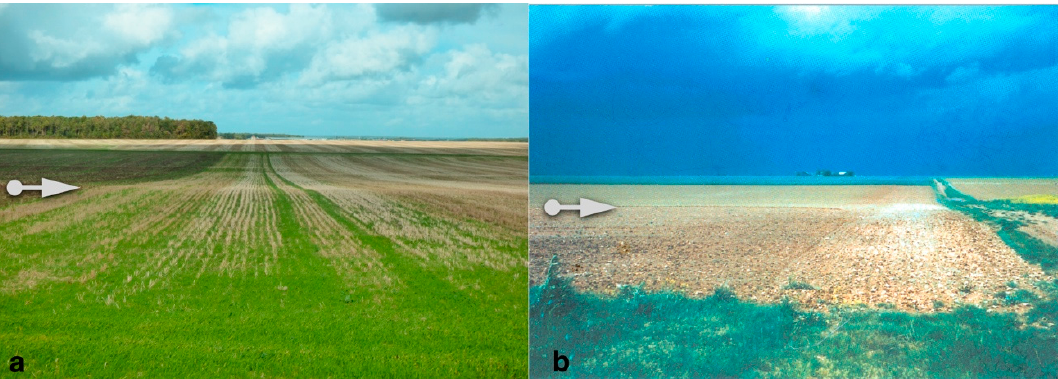
Figure 9. Remains of headlands in the Beauce region: ( a ) Remains of headlands parallel to the road into a large contemporary field in Baccon, source N. Levoguer, ( b ) remains of headland crossing a formal pathway in Toury-en-Beauce, source Collectionneur de Toury 28.